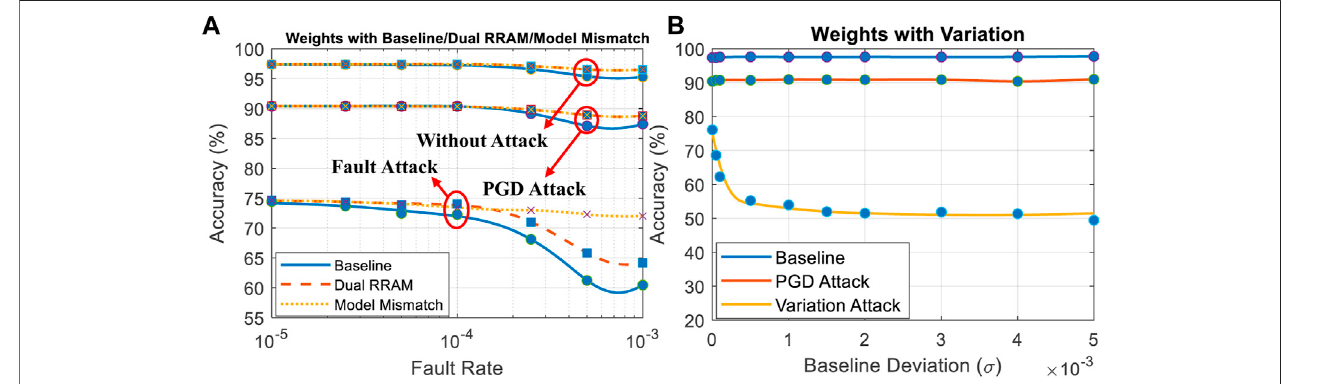
FIGURE 7 | (A) Results of Attack Model 1, and (B) results of Attack Model